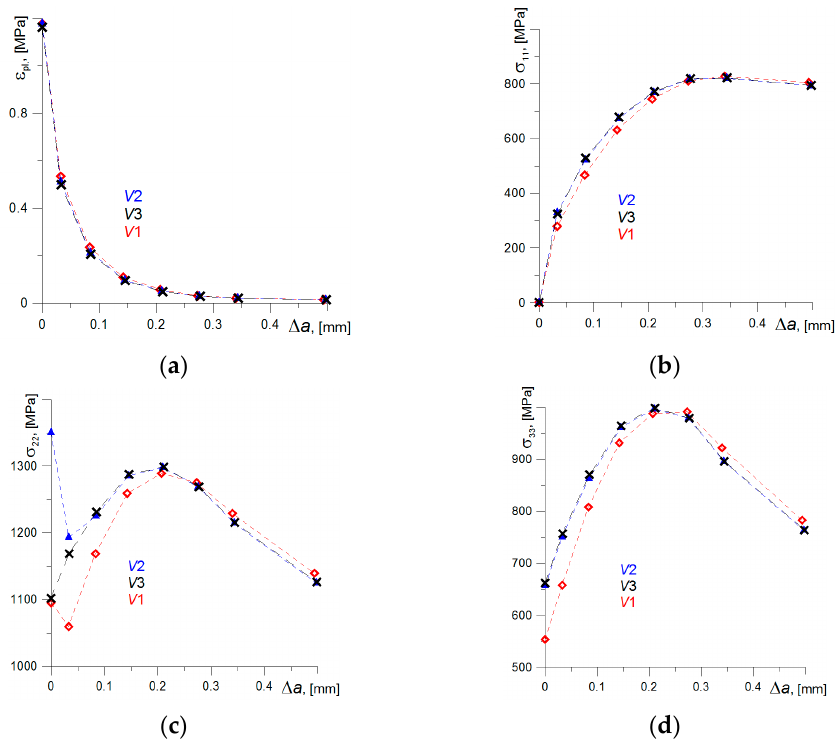
Figure 14. The distributions of plastic strains ( a ) and of stress components ( b – d ) in front of the crack calculated by means of FEM.